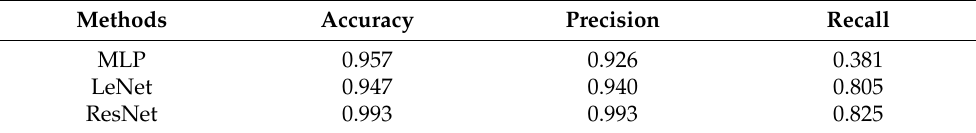
Table 5. Comparison of the results obtained by the three models for the Shangmao landslide. Methods